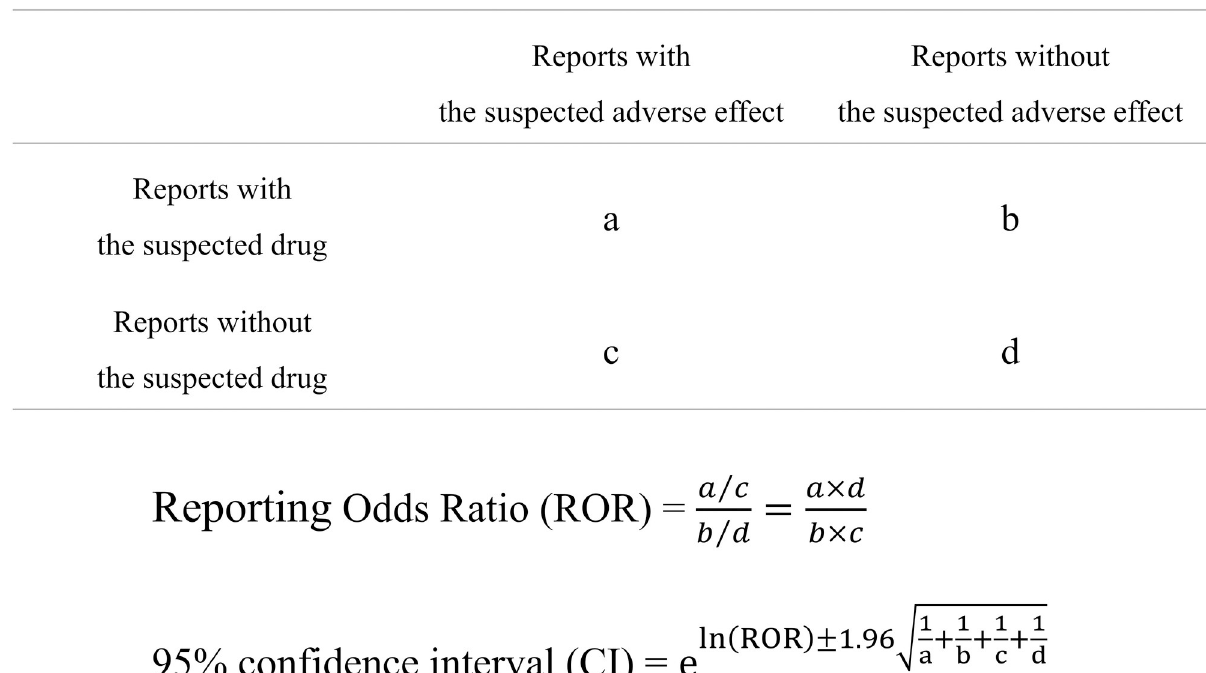
Fig 1. Two–by–two contingency table and calculation formula of ROR. The two–by–two contingency table contains reports with the suspected drug, reports without the suspected drug, reports with the suspected AE, and reports without the suspected AE (a–d indicate numbers of reports). The ROR and 95% CI were calculated as